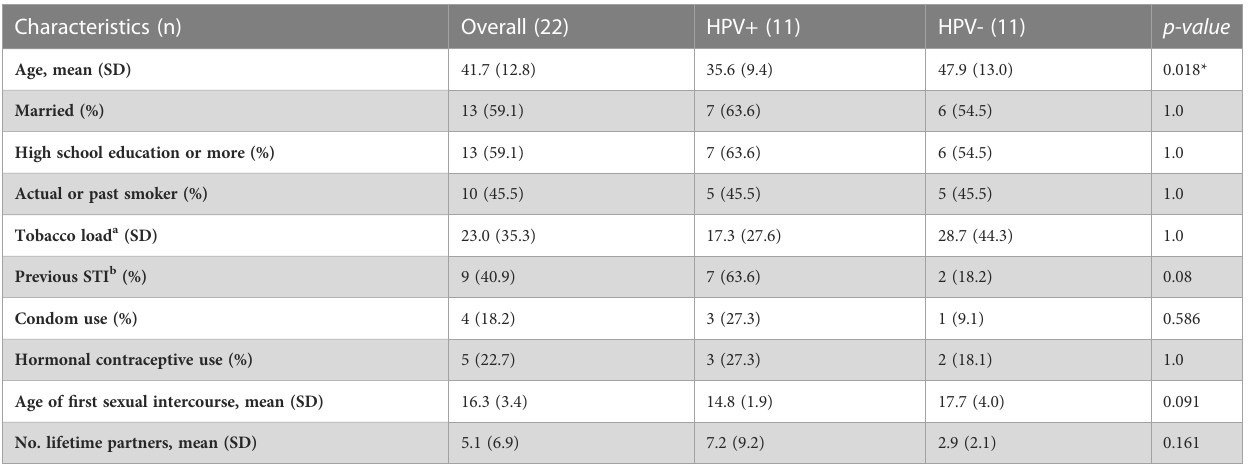
TABLE 1 Sociodemographic characterization of studied